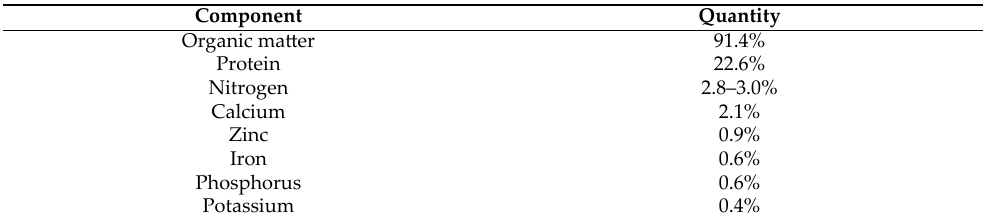
Table 1. Components of Paulownia leaves ([3,27], modified).